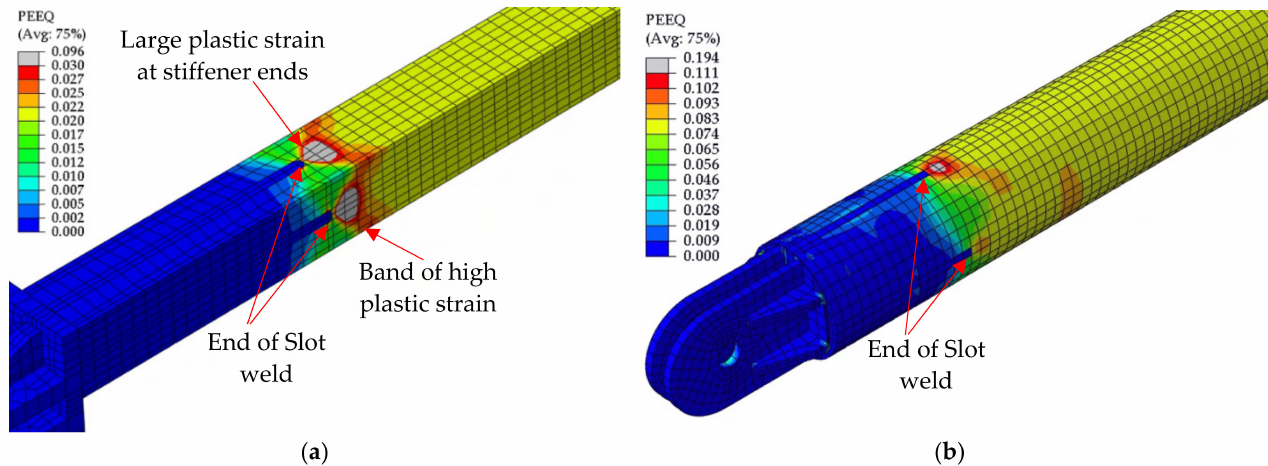
Figure 15. Equivalent plastic strain (PEEQ) distribution: ( a ) S125 t9–S200 t9-B at 0.5 ∆ bm ; ( b ) C216 t8–C267 t6-B3 at 2.0 ∆ bm